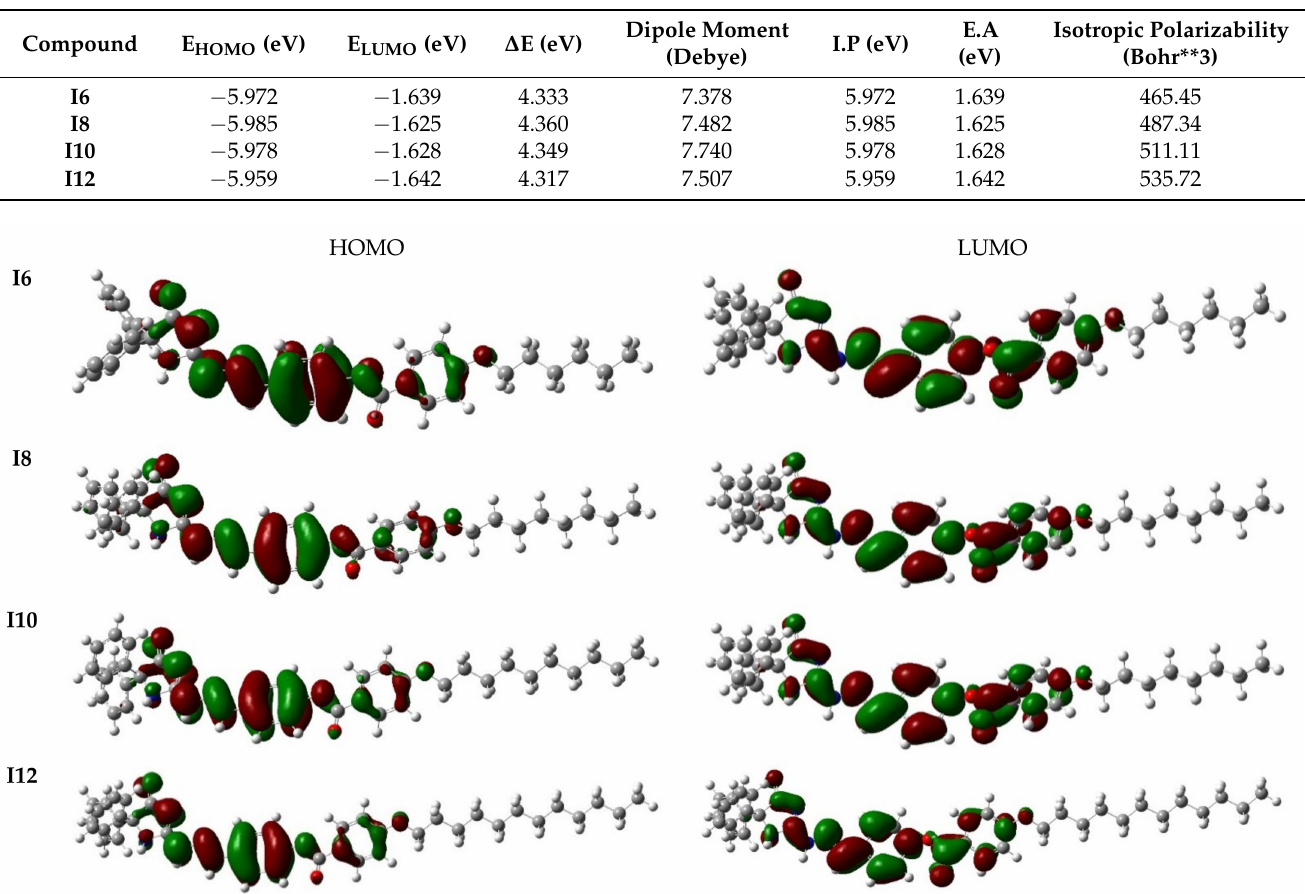
Reactivity parameters, dipole moment and polarizability computed at B3LYP/6- 31g(d,p) level.